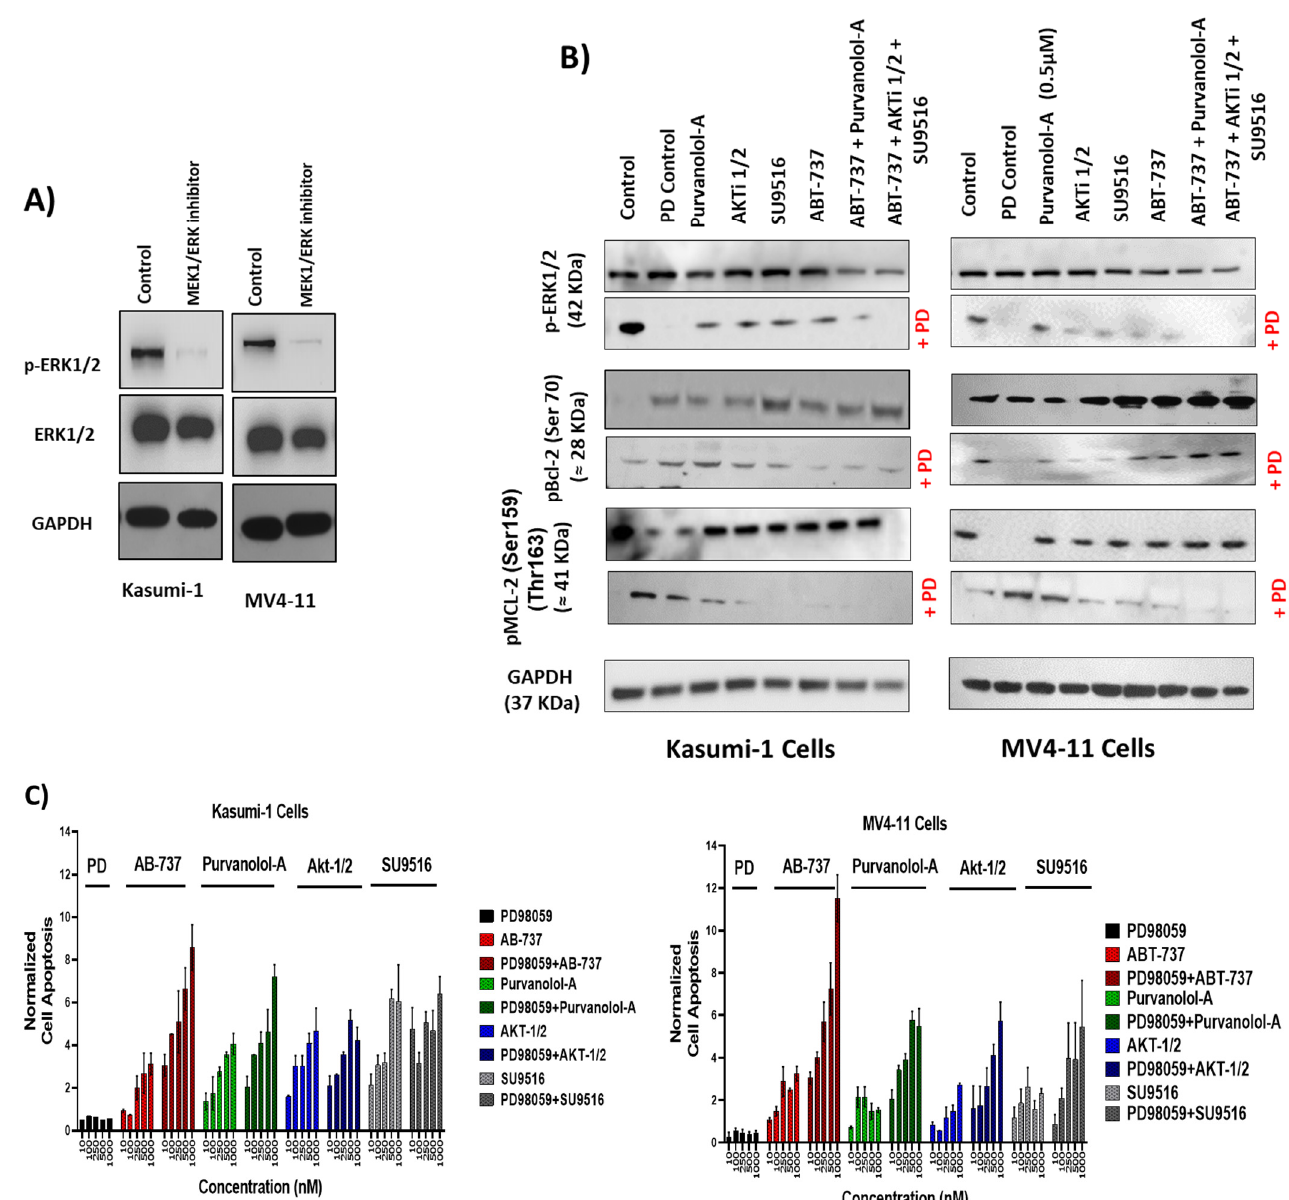
Figure 7. Bcl ‐ 2 phosphorylation was regulated by extracellular signal ‐ regulated kinase (ERK). 1 and MV4-11 cell lines were treated with 1 µ M PD98059, and total protein extracts were analysed Kasumi ‐ 1 and MV4 ‐ 11 cell lines were treated with 1 μ M PD98059, and total protein extracts were analysed by Western blot for the expression of ERK/Perk ( A ) and pBCL ‐ 2(Ser70), pMCL ‐ 2 by Western blot for the expression of ERK/Perk ( A ) and pBCL-2(Ser70), pMCL-2